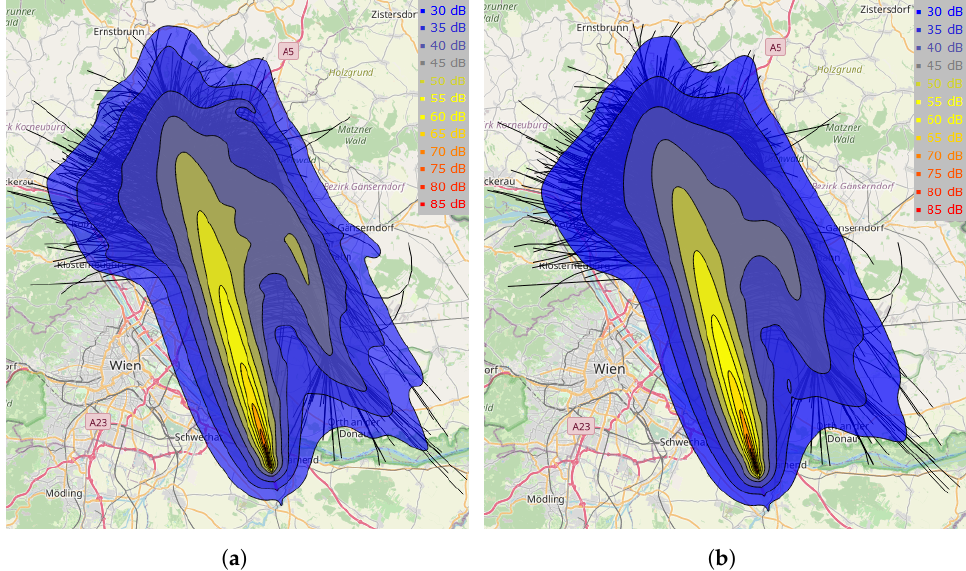
Figure 5. Noise contours ( L den ) ranging from 30 to 85 dB for actual arrival trajectories ( a ) and CDO trajectories ( b ) for Vienna airport TT dataset in October